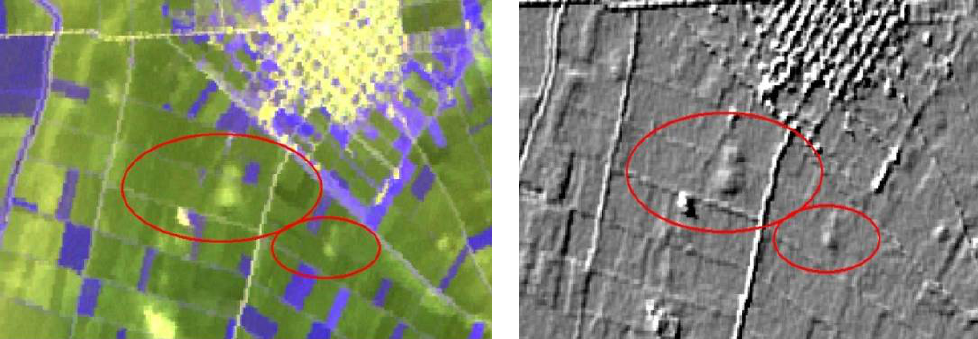
Figure 16. Original ASTER image (RGB → 1,2,3) around Halki area (Top Left) and the corresponding image after the application of Sobel Right Diagonal filter (Top Right). Original ASTER image (RGB → 1,2,3) around the settlements of Elliniko 1 and Elliniko 2 (Bottom Left) and the corresponding image after the application of Laplace Filter (Bottom